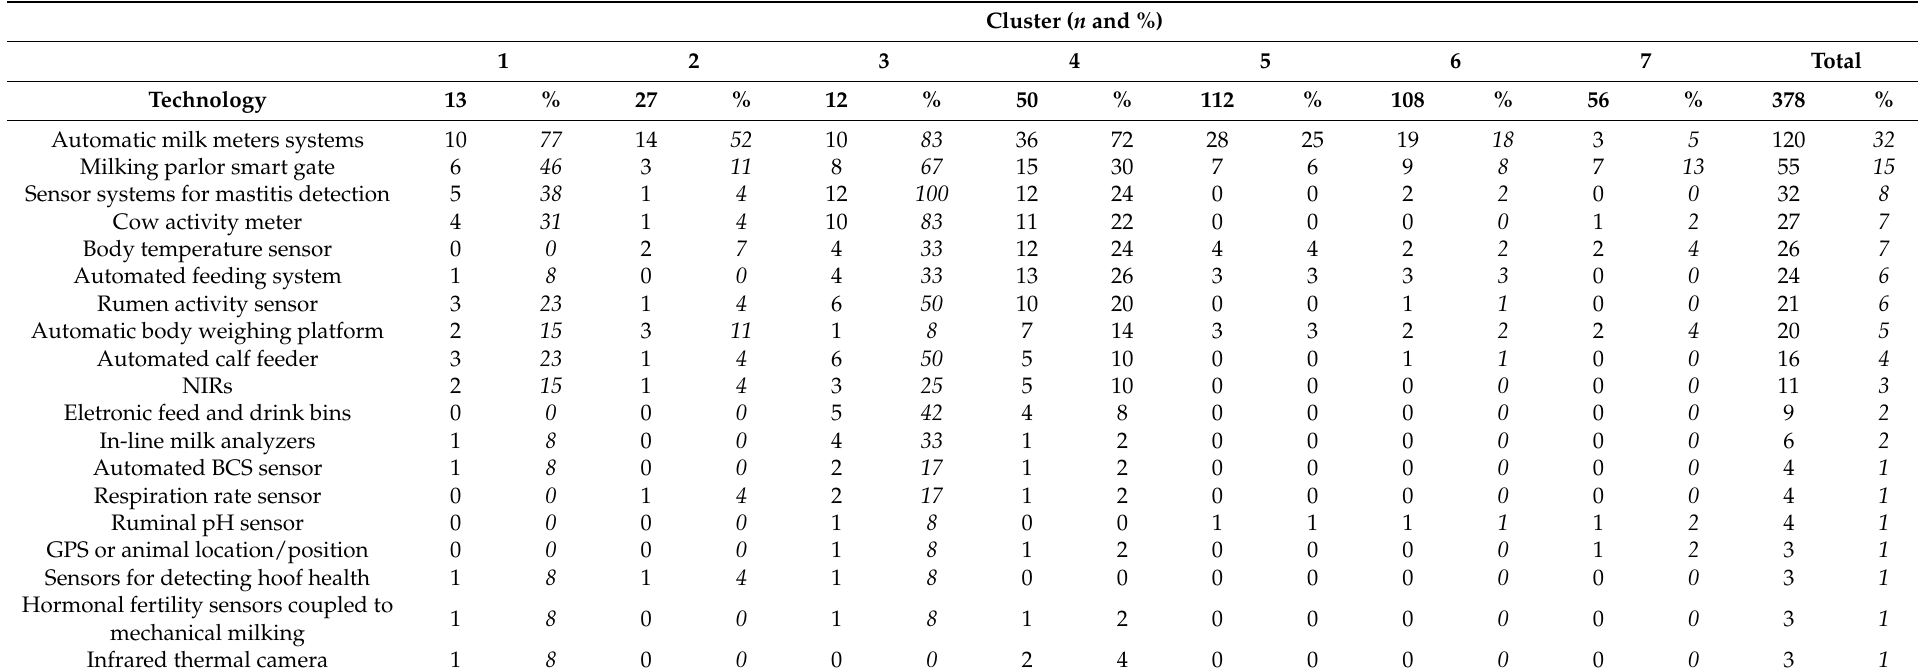
Table 8. Technologies used by